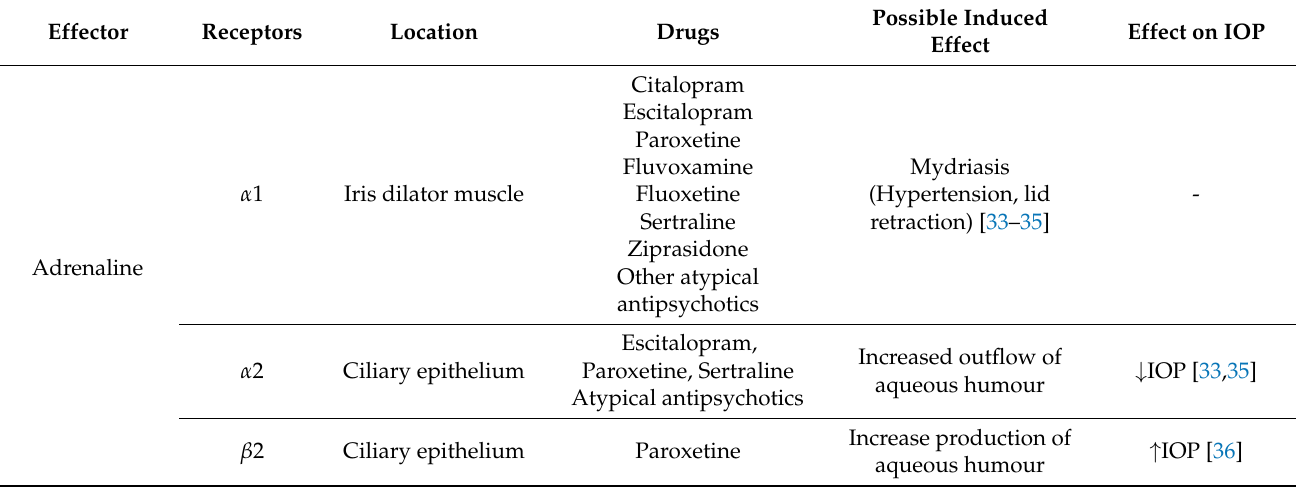
Table 1. Mechanisms of ction of psychopharmacological drugs and their possible effect on intraocular pressure, pupil size and glaucoma